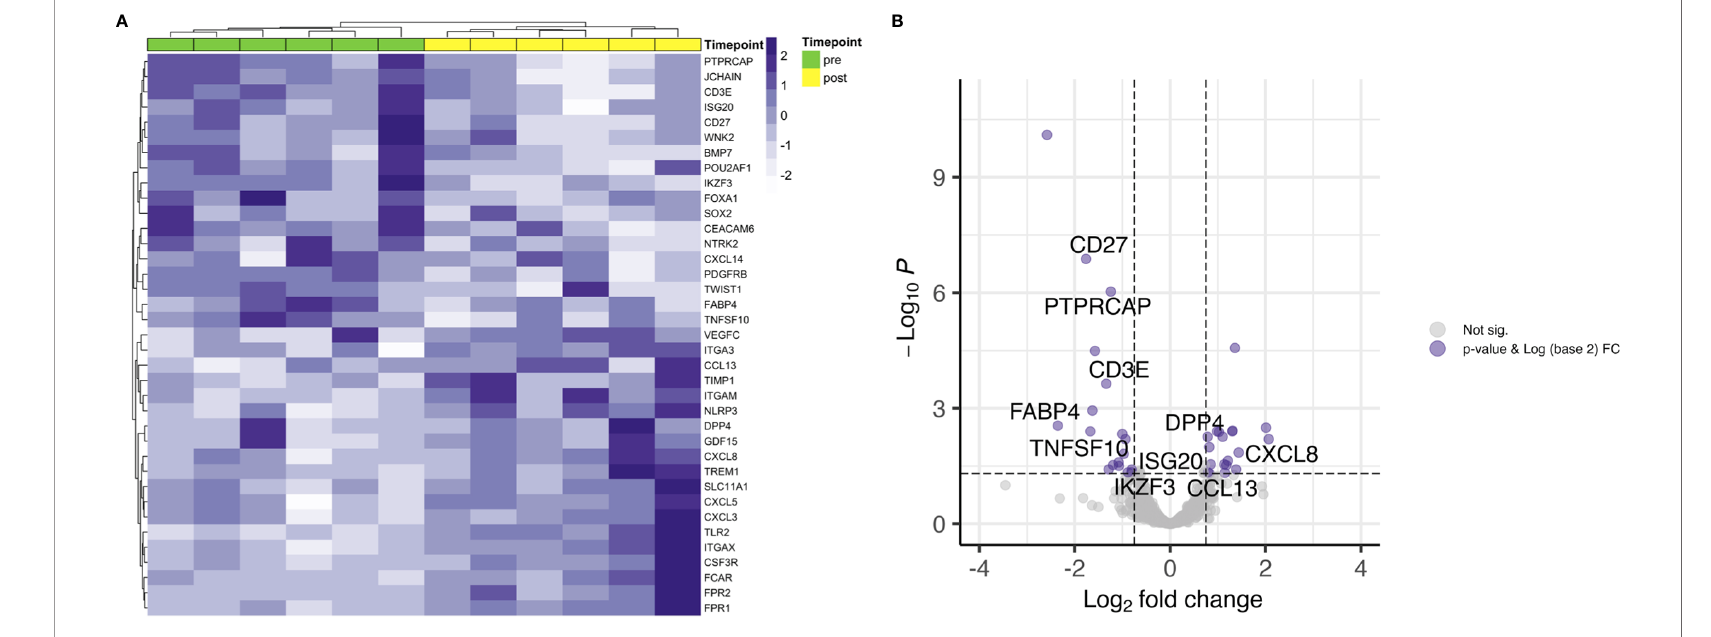
FIGURE 2 | Differential gene expression of RD samples before and after CRT. (A) Unsupervised hierarchical clustering using Euclidian distance for genes with expressed with an FDR < 0.05 and a log2 FC over 0.75 shows clear distribution in pre- and posttreatment samples. (B) T cell related genes are downregulated after CRT in patients with